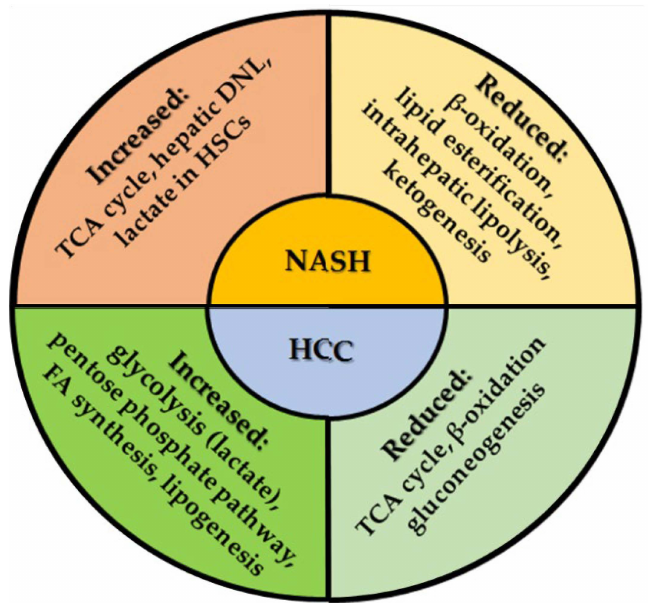
Figure 3. Dysregulation of metabolic pathways in NASH and HCC. There is an increase in the TCA cycle and lactate (HSCs) production in NASH, while β -oxidation, lipid esterification, and intrahepatic lipolysis are decreased, leading hepatic steatosis. The tumor cells express an increase of glycolysis with production of lactate (Warburg effect), elevated pentose phosphate pathway (nucleotide synthesis for multiplying tumor cells), FA synthesis and lipogenesis. The tumor cells also show reduced TCA cycle, β -oxidation and gluconeogenesis, indicating that metabolic reprograming plays a key role in hepatocarcinogenesis. Abbreviations: DNL, de novo lipogenesis; FA, fatty acid; HSCs, hepatic stellate cells; TCA, tricarboxylic